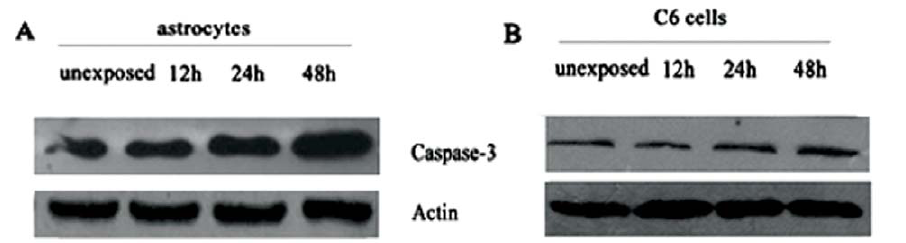
Figure 6. Increased caspase-3 detected in astrocytes after 48 h exposure. (A) Analysis for caspase-3 in astrocytes by western-blot, and a significant increase of caspase-3 protein was detected after 48 h exposure. (B) Caspase-3 expression in C6 cells was not influenced by RF emissions at any exposure time. Using b -actin as the loading control for standardization.